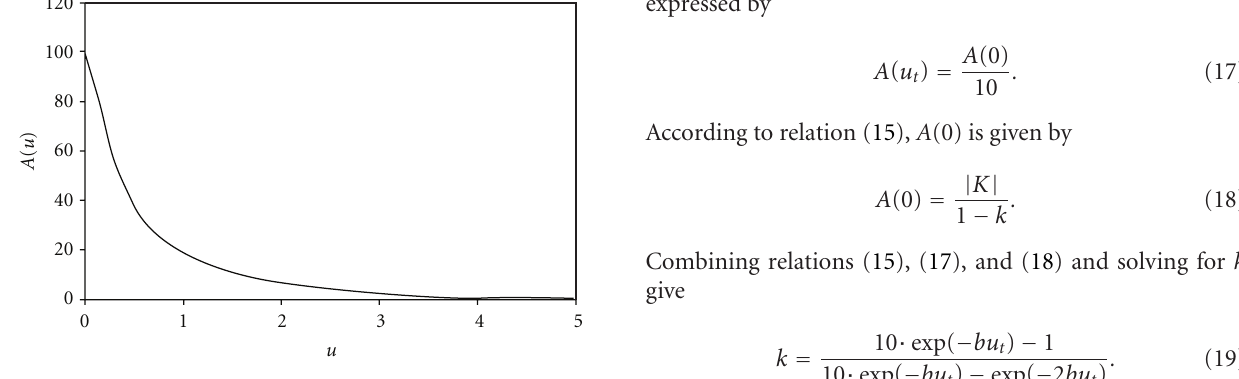
Figure 4: The amplitude spectrum of the self-potential anomaly V ( x ) : b = 1, K = 100, k = 0 . 5.